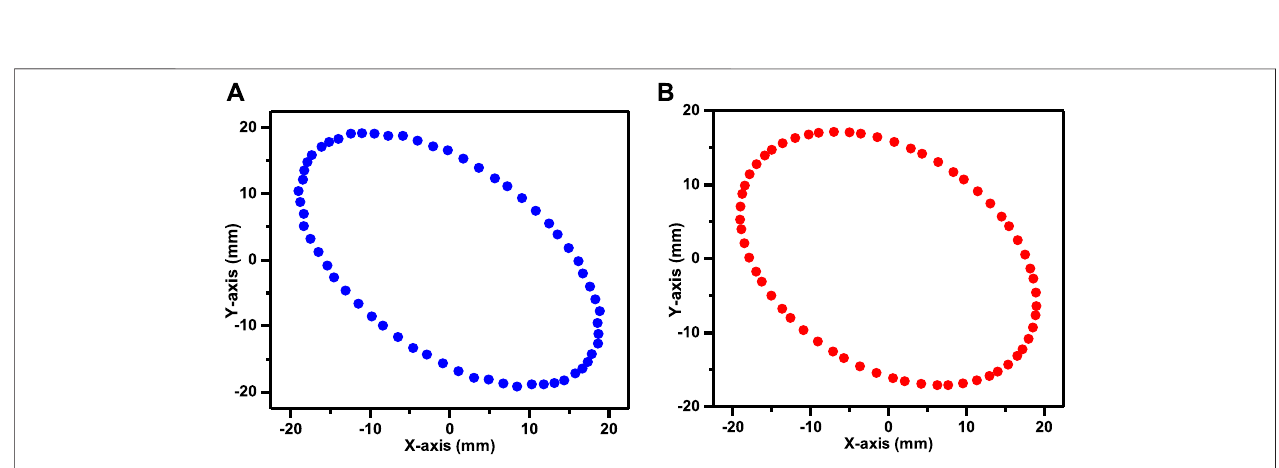
FIGURE7|(A,B) ThespotpatternsofthreedifferentMPCs( C bluedot, C reddot)onsphericalmirrorM 1 stimulatedbyopticalsoftwareandmodi fi edABCDmatrix model, respectively. The optical parameters of spot patterns are identical to that in Figure 4 .